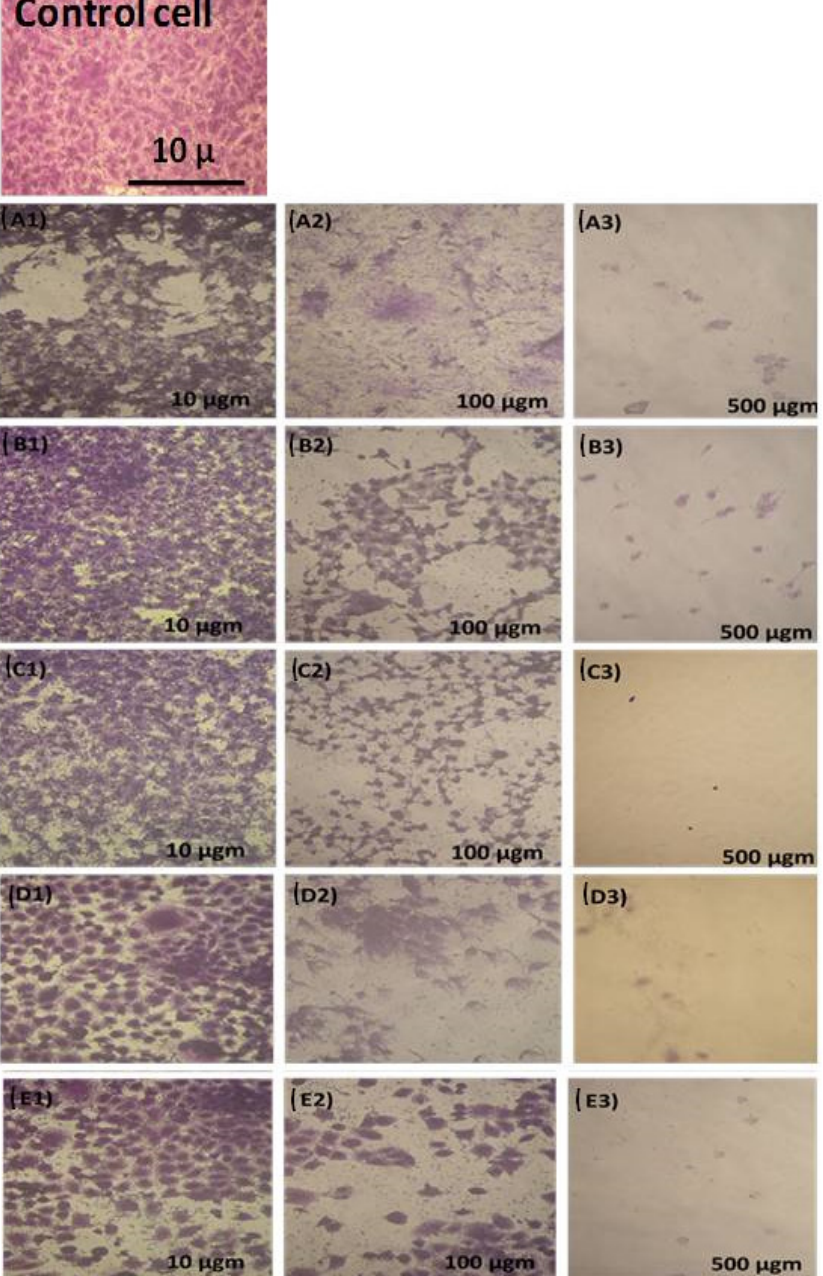
Figure 6. SEM images for HepG-2 cell control untreated sample and treated samples by 10 µgm ( A1 , B1 , C1 , D1 , E1 ),100 µgm ( A2 , B2 , C2 , D2 , E2 ), and 500 µgm ( A3 , B3 , C3 , D3 , E3 ).